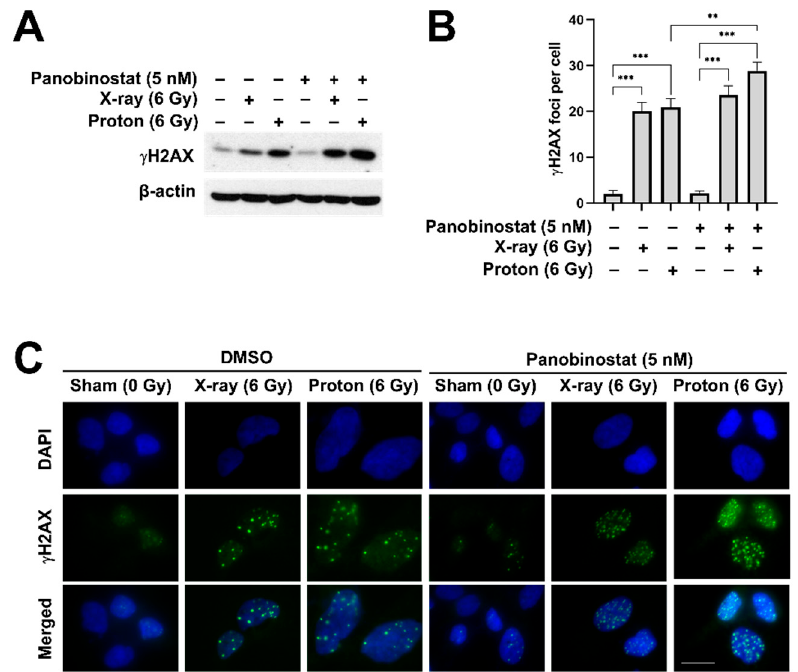
Figure 4. Effects of panobinostat combined with X-rays or protons on DNA damage in Huh7 cells. Huh7 cells were plated on cover slips and then were treated with 5 nM panobinostat 3 h prior to irradiation. The cells were irradiated with 6 Gy of X-rays or protons and the samples were prepared 24 h post-irradiation. ( A ) Western blotting showed that expression of γ H2AX, a sensitive marker for DNA double-stranded breaks, was increased by either X-rays or protons, which was further enhanced by pre-treatment with panobinostat. β -actin was used as a loading control. ( B ) Quantification of γ H2AX foci in the nuclei of the Huh7 cells irradiated with X-rays or protons. The data represent the mean ± S.D. (n = 3); ** p < 0.01; *** p < 0.001. ( C ) Representative immunofluorescence images of γ H2AX. Huh7 cells were pre-treated with 5 nM panobinostat, followed by 6 Gy of X-rays or protons. The cells were fixed and stained 24 h post-irradiation. Blue: DAPI; green: γ H2AX; scale bar: 20 μ m.